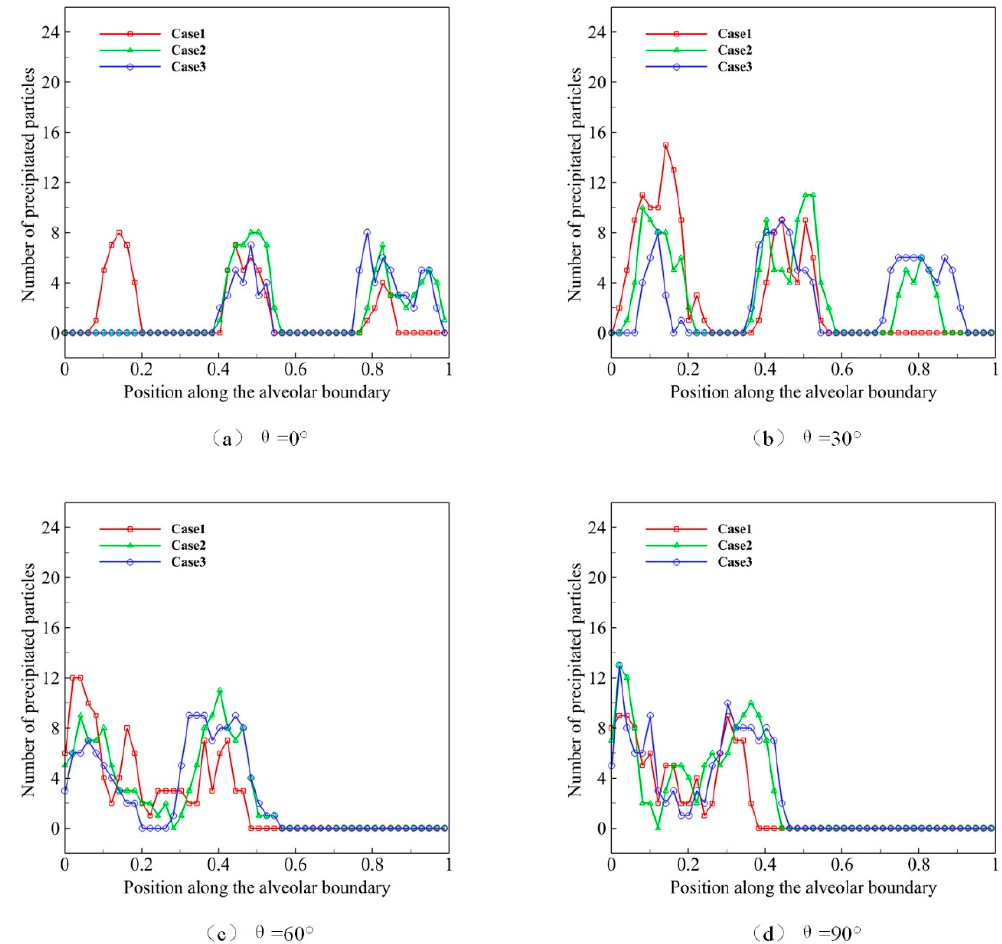
Figure 8. The deposition and distribution of microparticles in pulmonary acini at different respiratory depths.